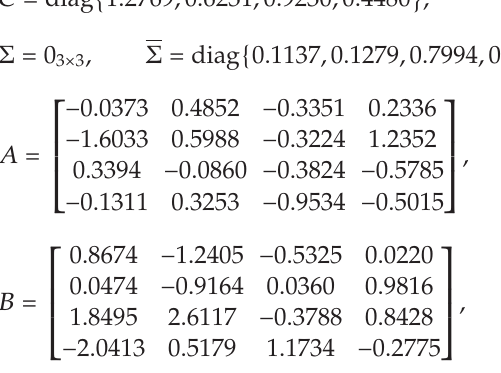
Table 2: Calculated MAUBs τ Methods \ μ 2 0 . 6 0 . 8 0 . 9 1 .